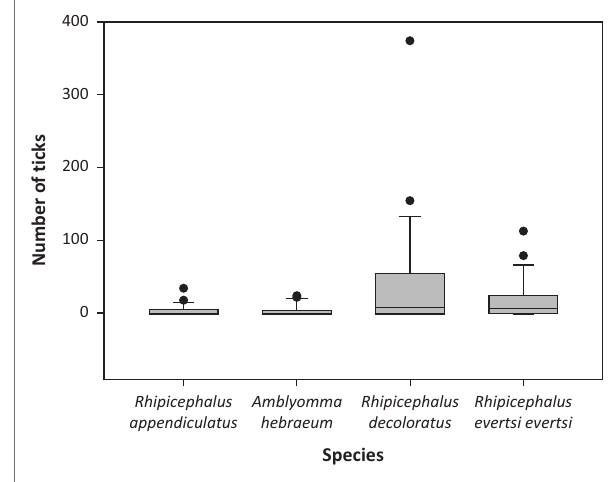
FIGURE 3: Boxplot depicting the significant difference in abundance between individual tick species in the woodland of the sable antelope breeding enclosures on the Farm Hoopdal KQ96. The middle bar, the box and the whiskers refer to the median, the interquartile range and the interoctile (80 % ) range, whilst the dots are extremes or outliers.